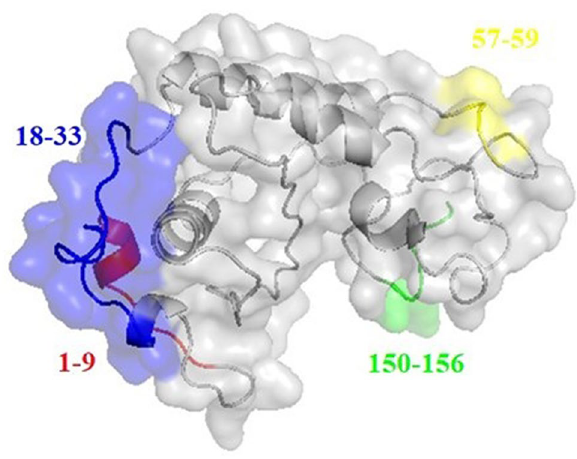
Figure 4. The four predicted consensus B-cell epitopes of NIE (residues 1–9, 18–33, 57–59 and 150–156). Figure was prepared by PyMol ver 2.4.0 (https ://pymol